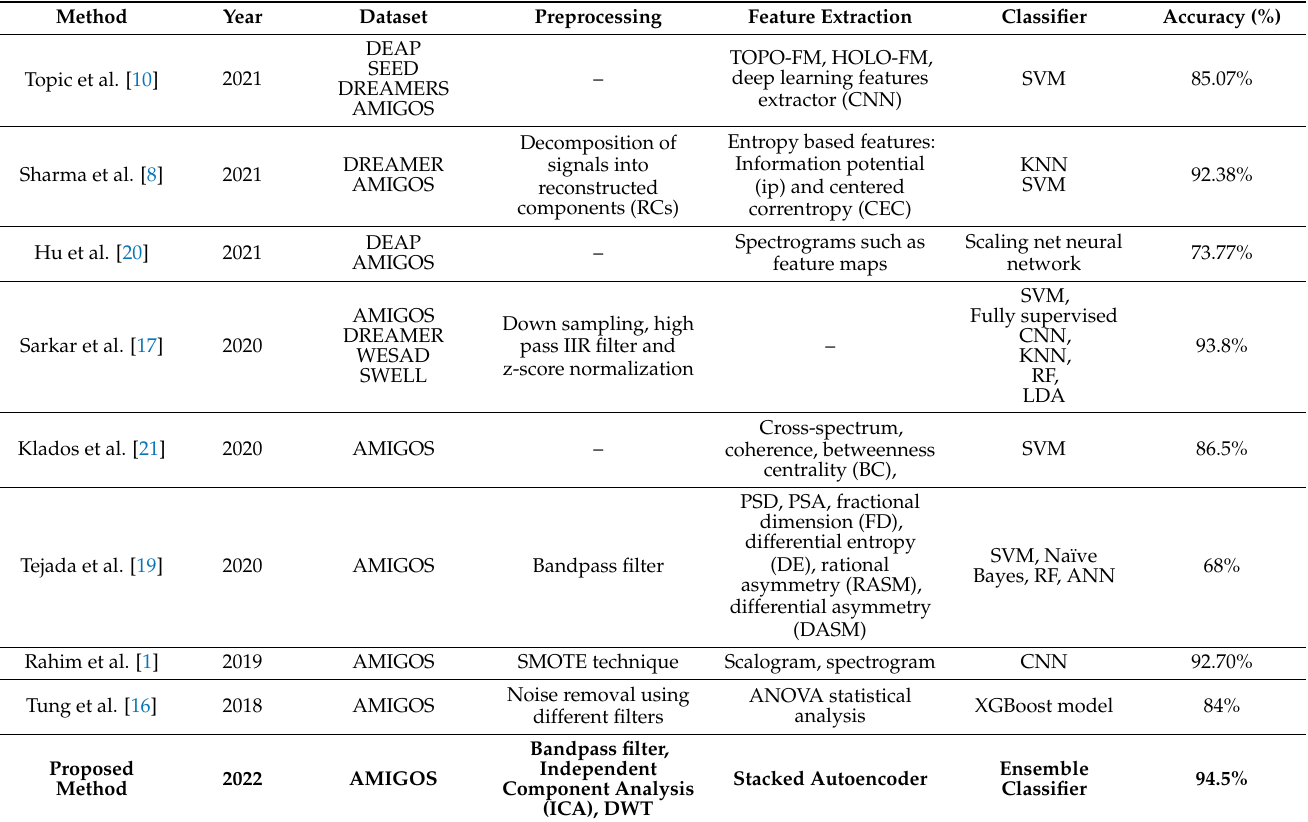
Table 2. Comparison of proposed approach with existing methods.